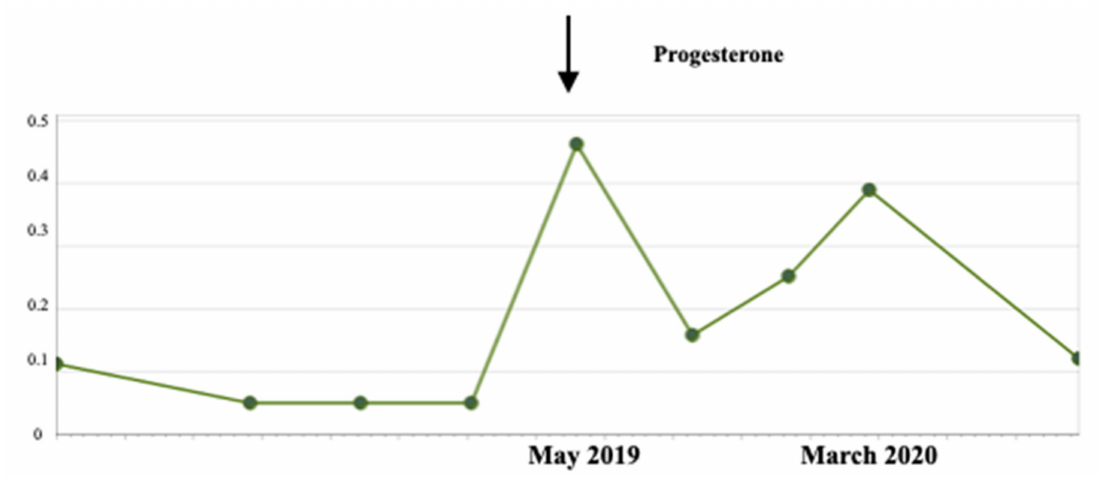
Figure 3. Evolution of estradiol and progesterone values before and after starting hormone treatment (July 2019).